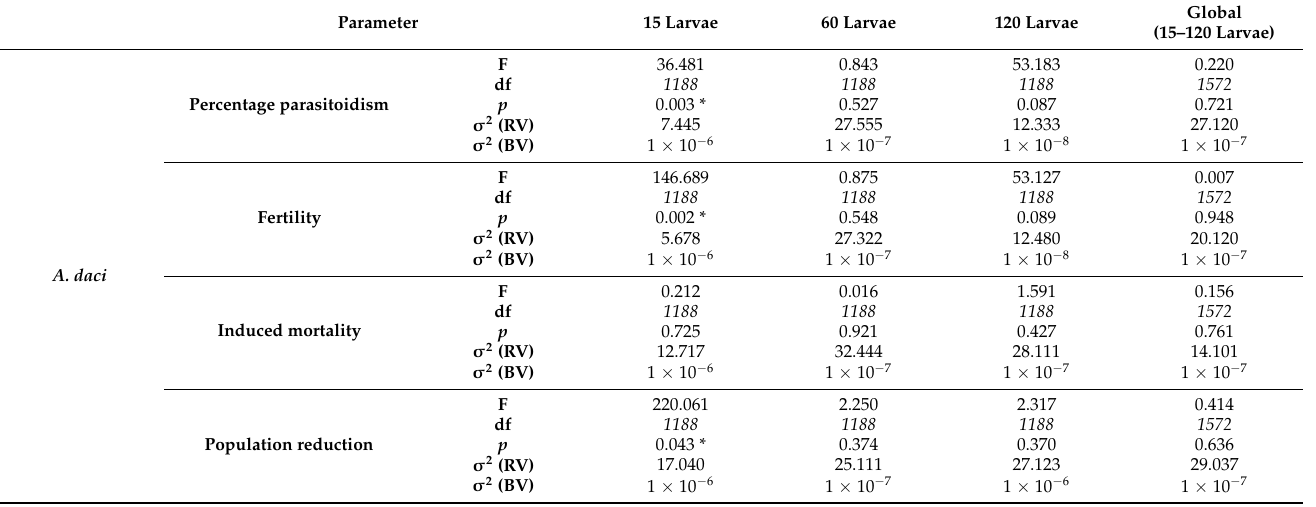
Table 3. Two-way ANOVAs comparing percentage parasitoidism, fertility, induced mortality and population reduction of A. daci and predation of P. rufipe , between the two situations considered (acting alone vs. acting jointly) at the three Medfly densities established (15, 60 and 120 larvae/pupae) and globally (15–120 larvae/pupae). df = degrees of freedom; RV = residual variance; BV = block variance. Asterisks (*) indicate significant differences in each comparison.